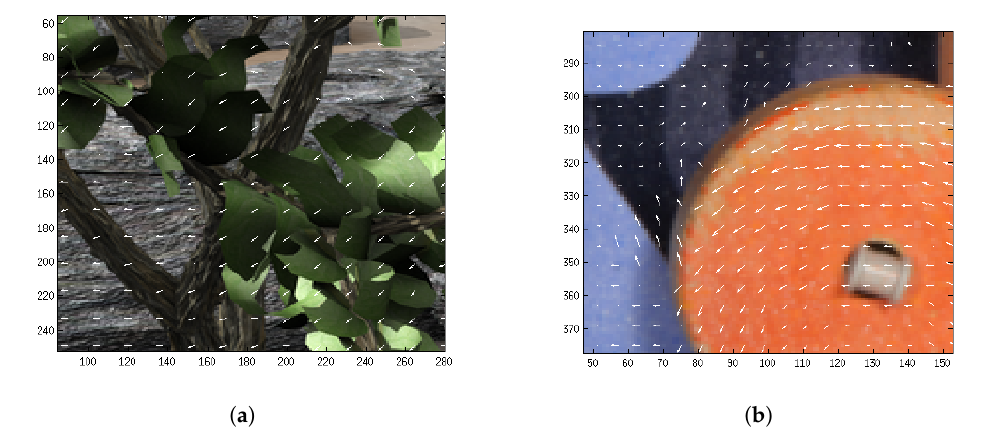
Figure 18. Exhaustive matching represented with white arrows. ( a ) Exhaustive matching using D = 18 and P = 10 for Grove2. ( b ) Exhaustive matching using D = 6 and P = 8 for